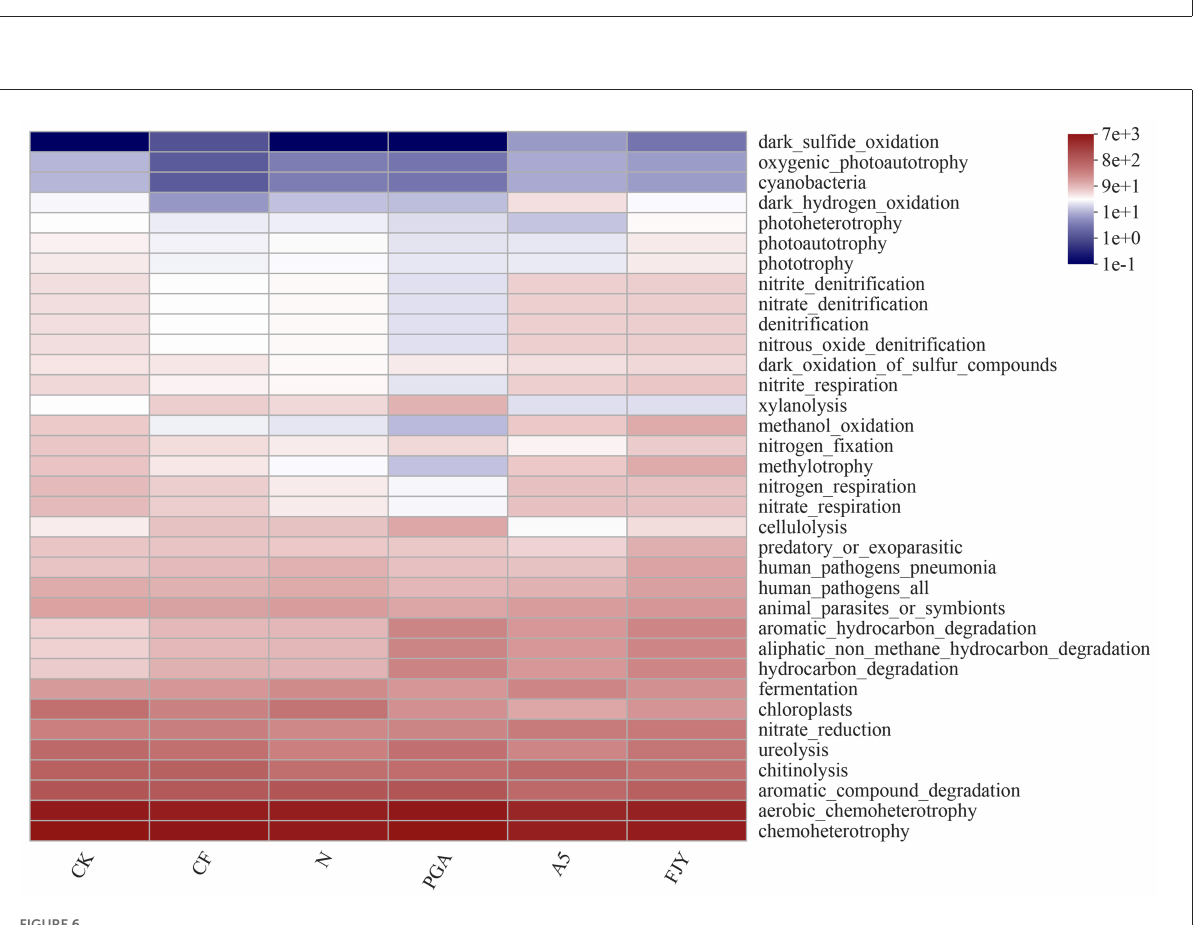
FIGURE6 Functional heatmap of the rhizosphere soil predicted by the FAPROTAX database under different